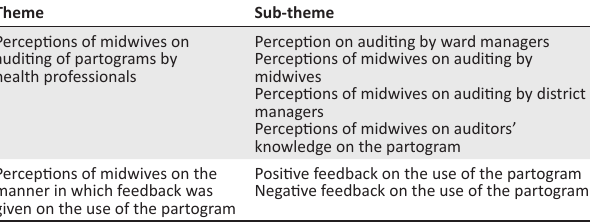
TABLE 1: Themes and sub-themes on auditing and giving feedback on the use of the partogram.